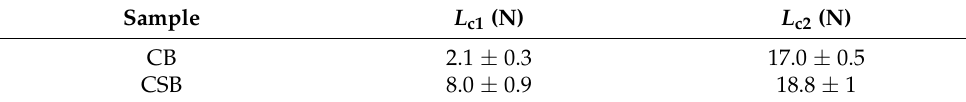
Table 2. First critical load ( L c1 ) and second critical load ( L c2 ) of the samples.